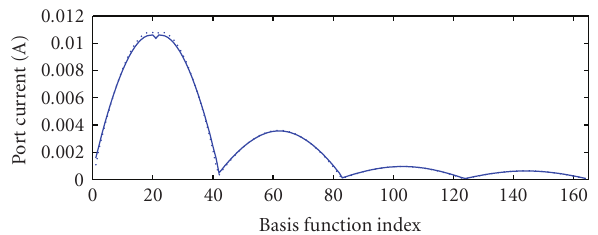
Figure 8: Currents on four parallel dipoles. Solid: our code. Dotted: NEC2